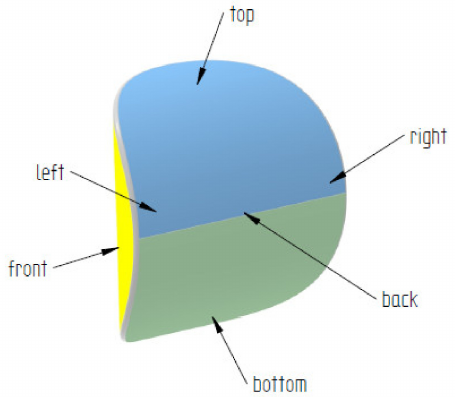
Figure 4. Saddle-shaped briquette with selected markings.